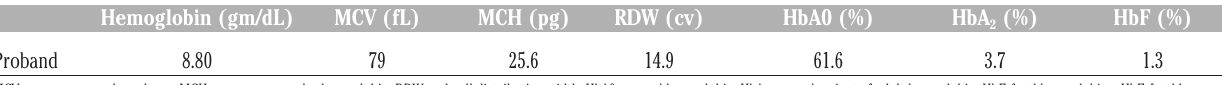
Table 2. Complete hemogram of Case 2 after 3 months of iron supplement. Hemoglobin